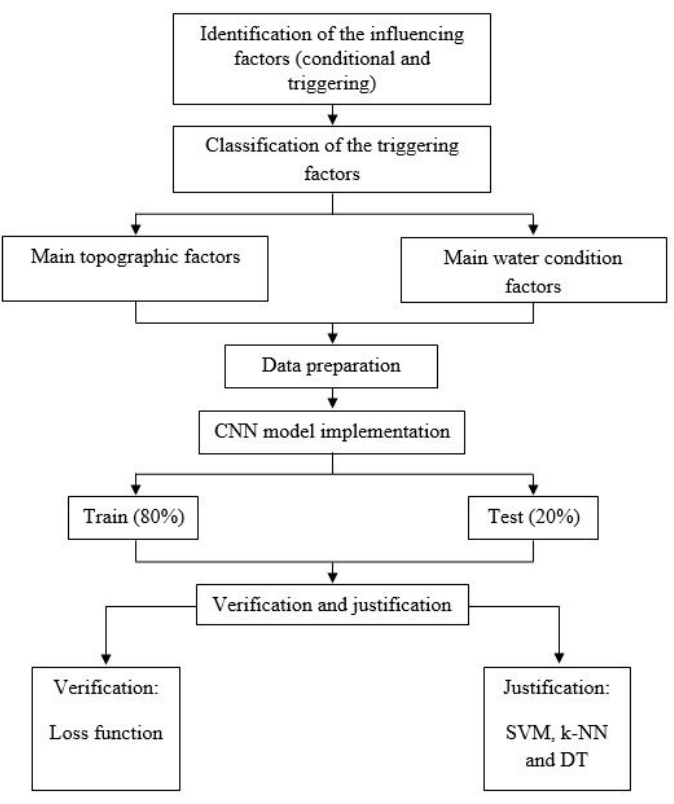
Figure 7. Flowchart of the CNN-based methodology. Table 1. Relations between the triggering factors and landslide susceptibility